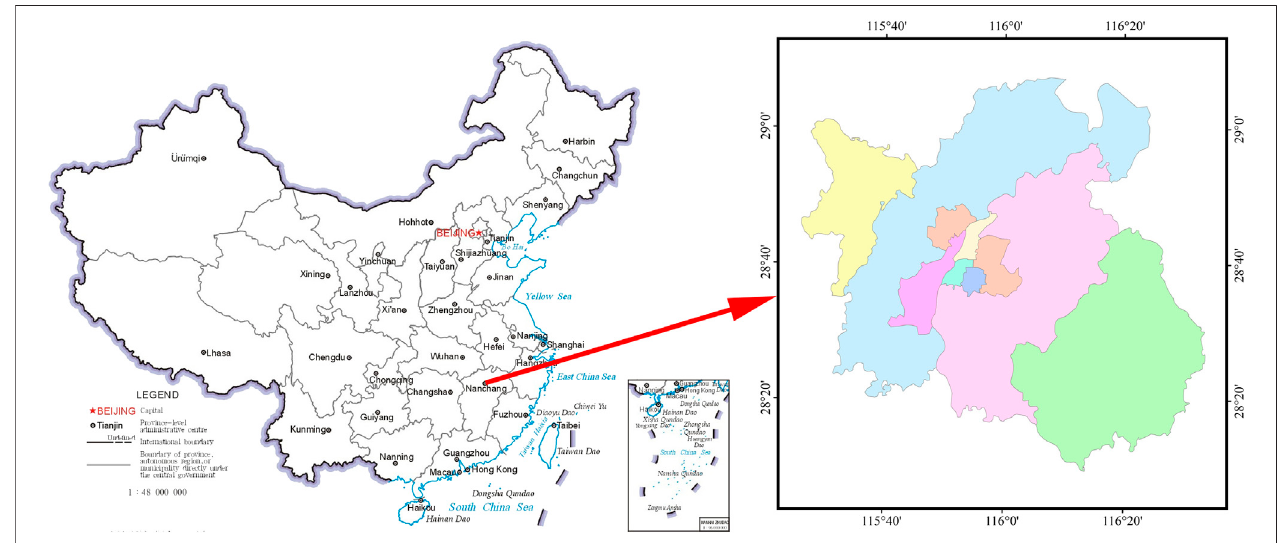
FIGURE 1 | The study